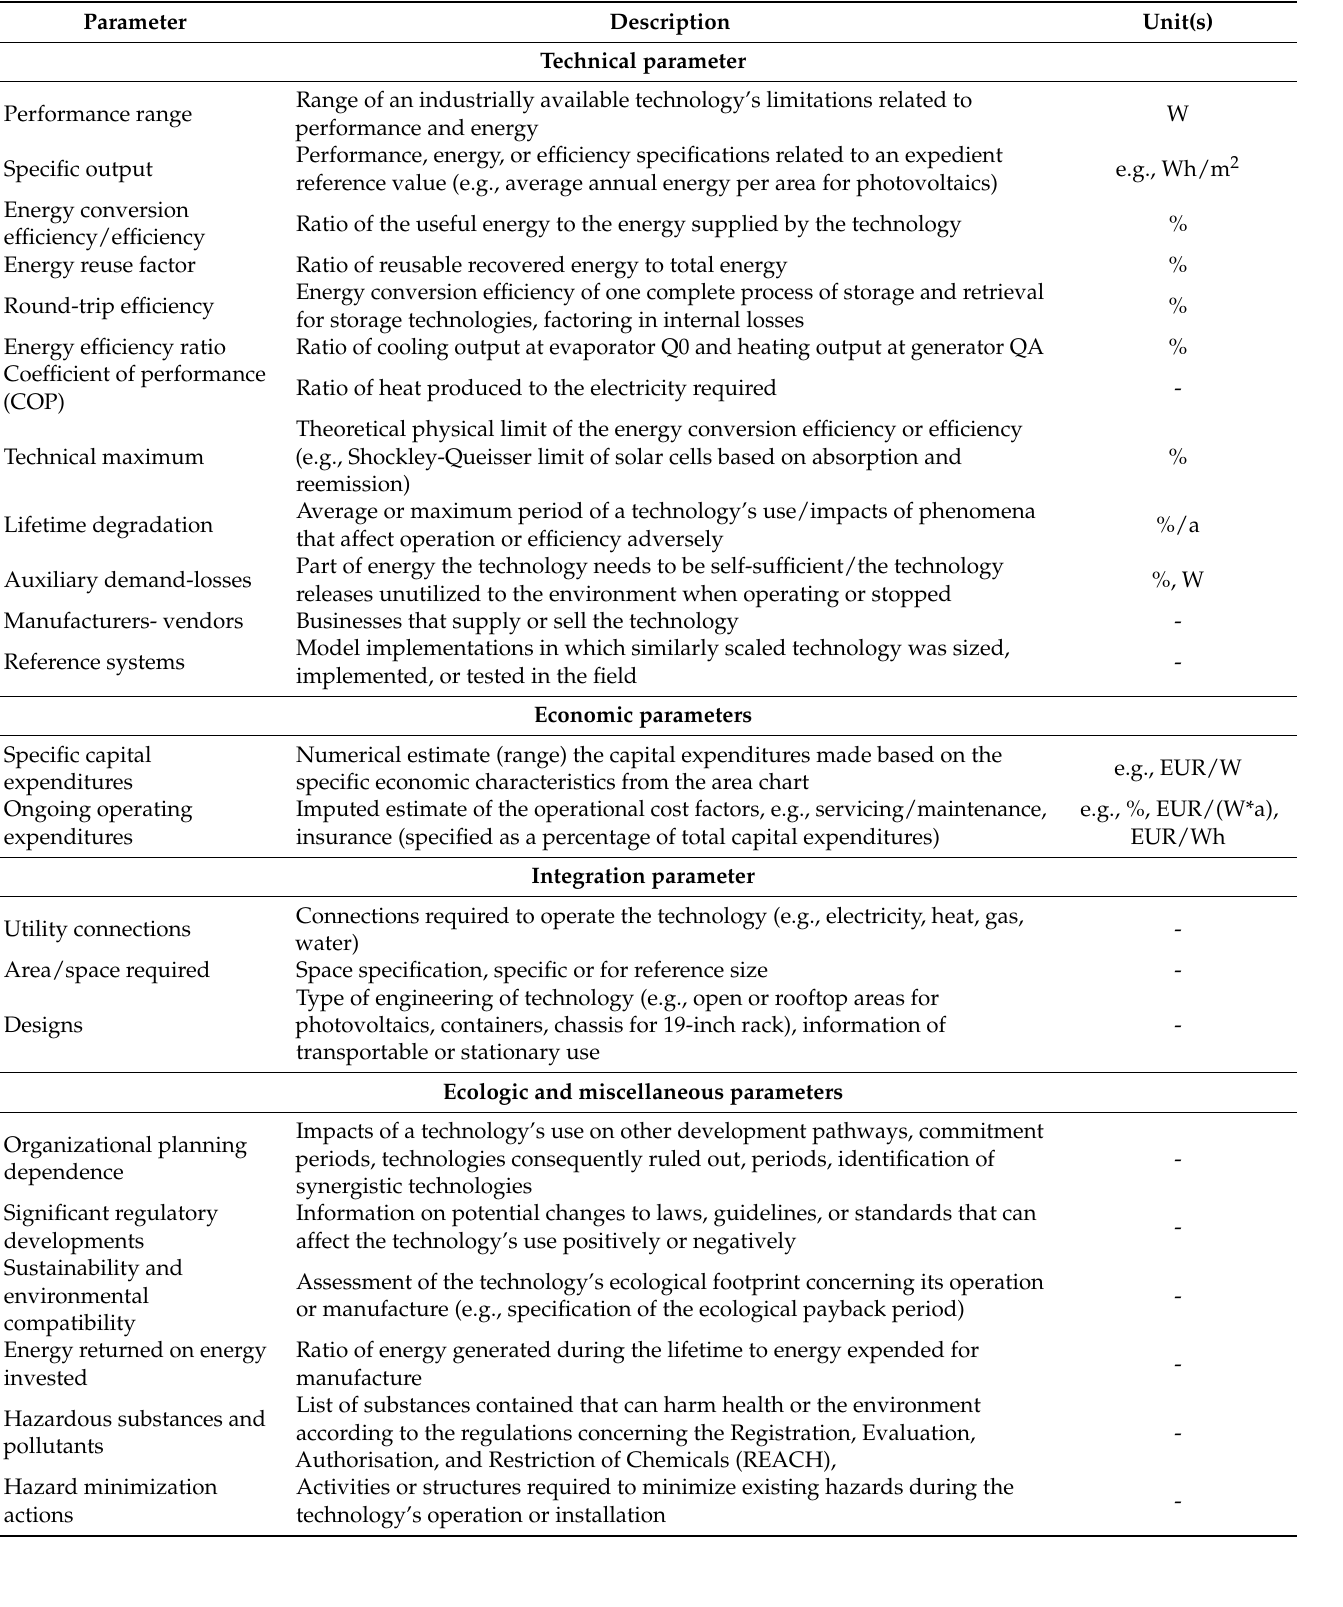
Table 4. List of typical